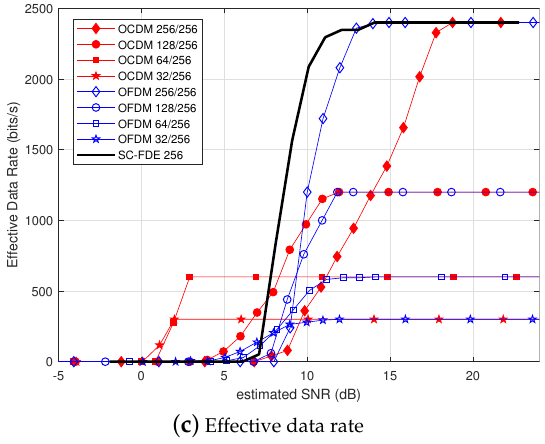
Figure 8. System performance comparison of OCDM, OFDM and SC-FDE over the Watermark NOF1